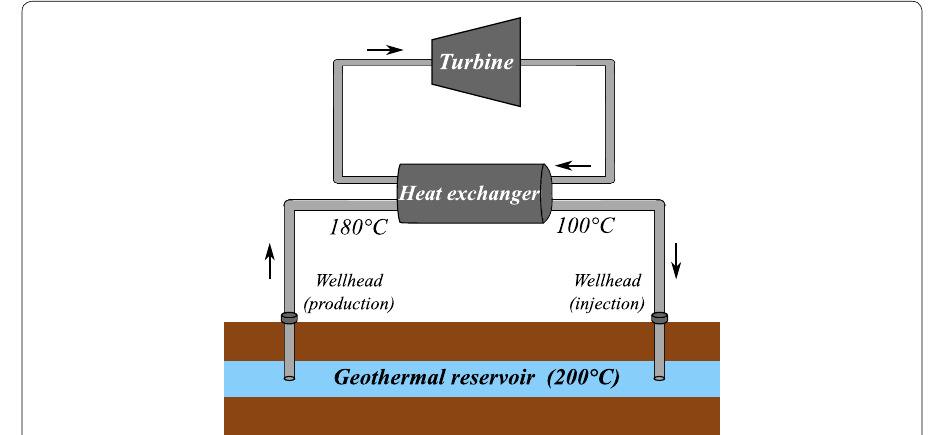
Fig. 1 Schematic drawing of a binary cycle geothermal power plant showing the main components (well casings, wellheads and heat exchanger) that are in contact with the produced and spent geothermal